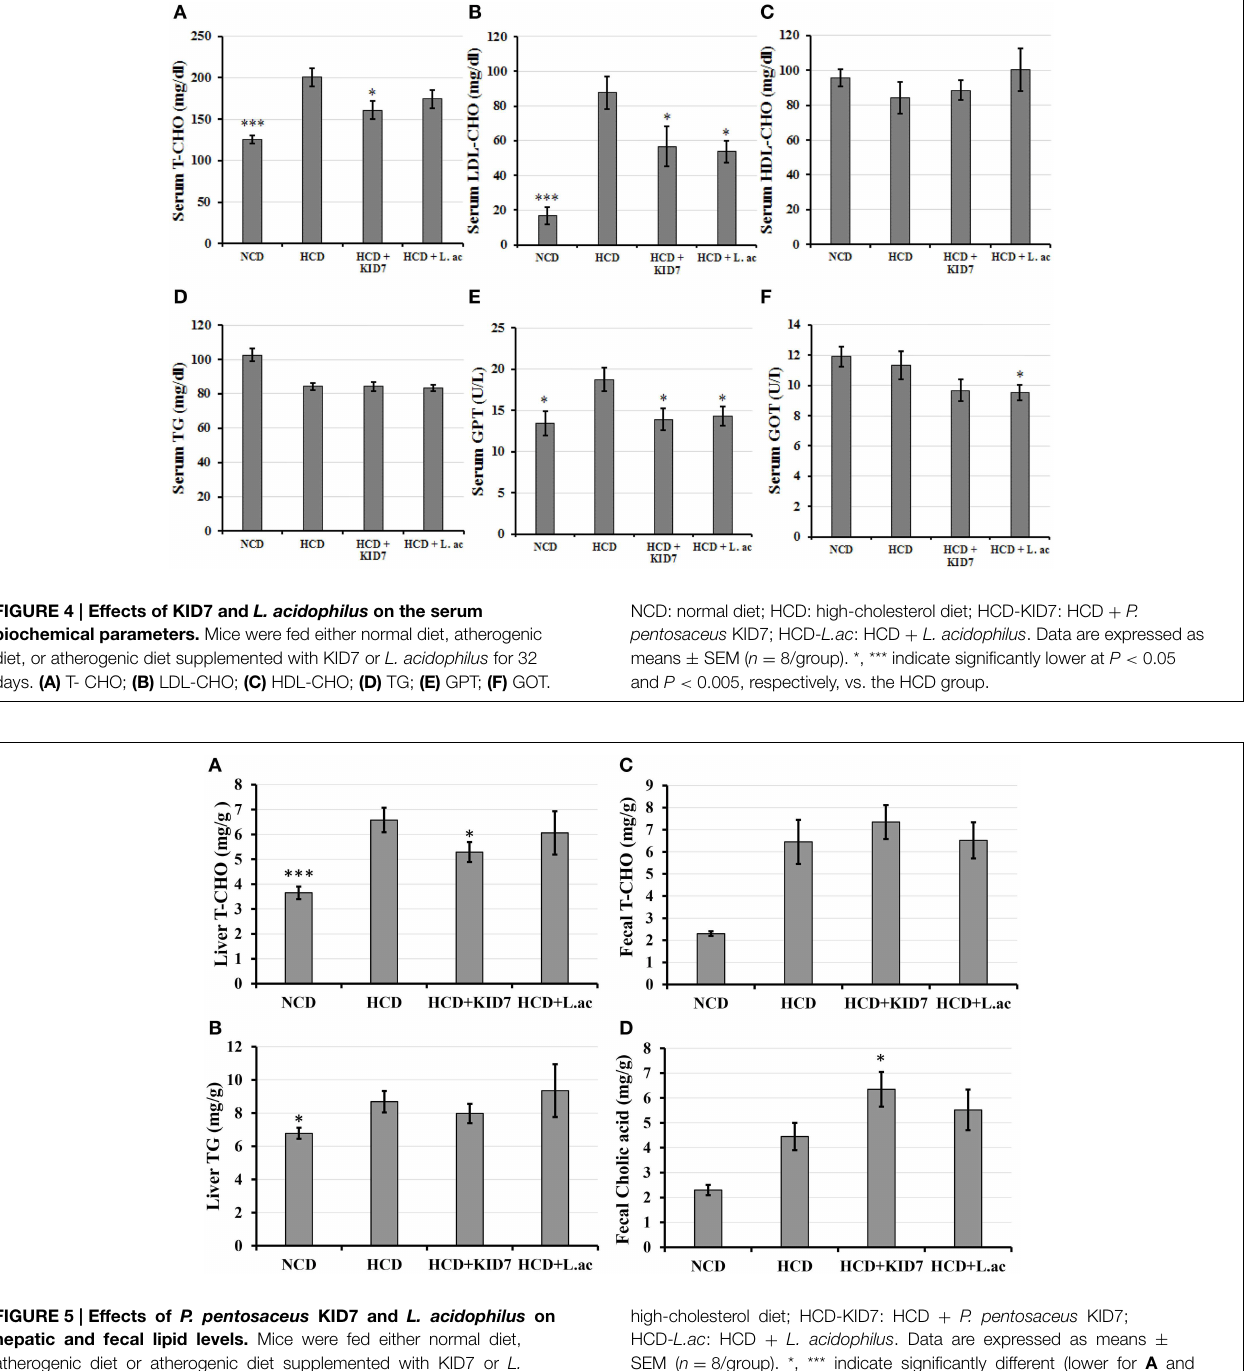
FIGURE 5 | Effects of P. pentosaceus KID7 and L. acidophilus on hepatic and fecal lipid levels. Mice were fed either normal diet, atherogenic diet or atherogenic diet supplemented with KID7 or L. acidophilus for 32 days. (A) Liver T-CHO; (B) Liver TG; (C) Fecal T-CHO, and (D) Fecal cholic acid contents. NCD: normal diet; HCD: